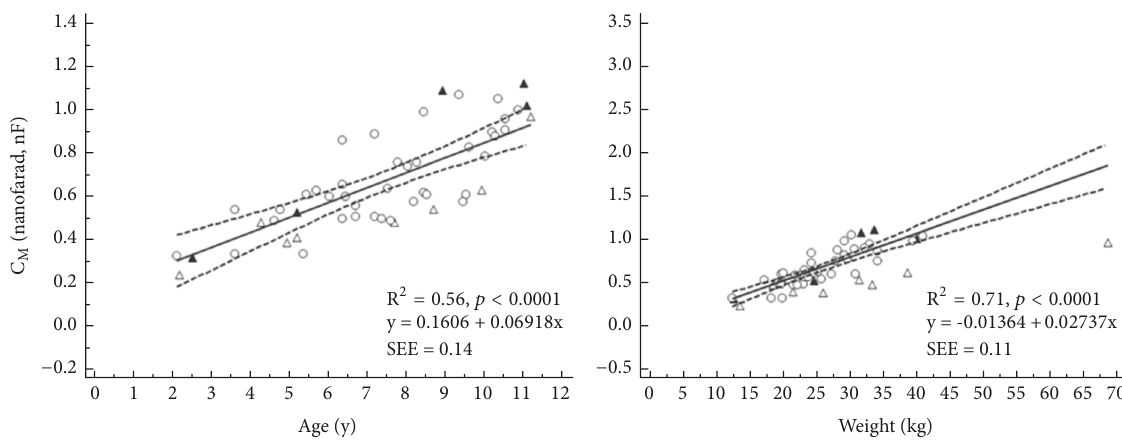
Figure 3: Relationship between cell membrane capacitance (C M ) and age (left panel) and weight (right panel); (cid:2) : ANS, 󳵳 : NSR, and I : HC, see Table 1 for group descriptions; dashed lines are 95% confidence intervals for regression lines based on the HC data.